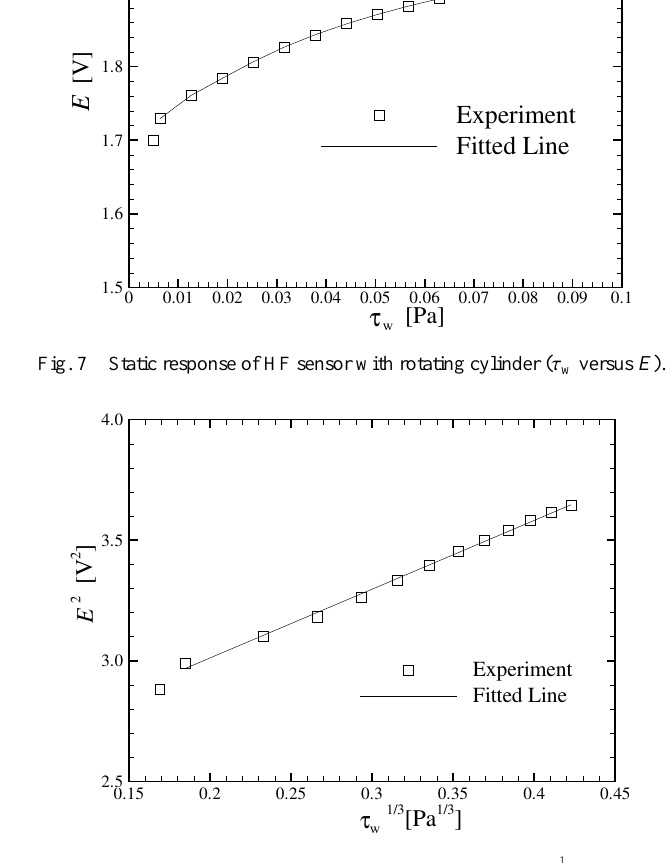
Fig. 8 Static response of HF sensor with rotating cylinder ( (cid:28)